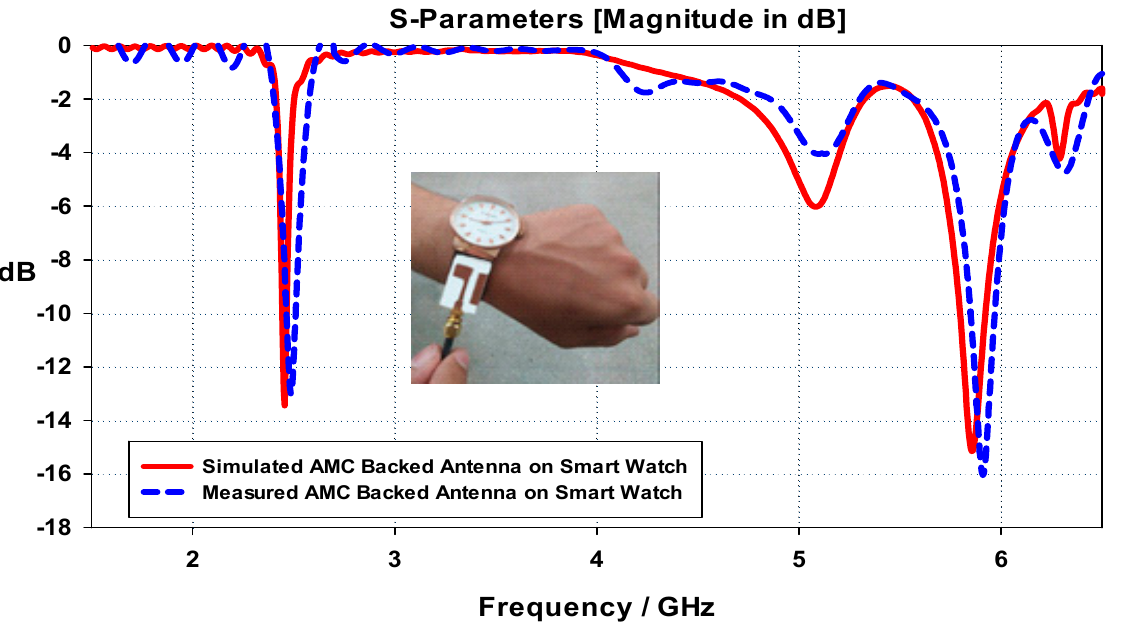
Figure 27. Comparison of simulated and measured reflection coefficients of the AMC-backed antenna on a human phantom. Figure 28 illustrates the simulated and measured radiation patterns of the proposed AMC-backed antenna on the E- and H-planes on the watch and human hand. The patterns indicate that the antenna is directional at both 2.45 and 5.8 GHz; thus, the antenna